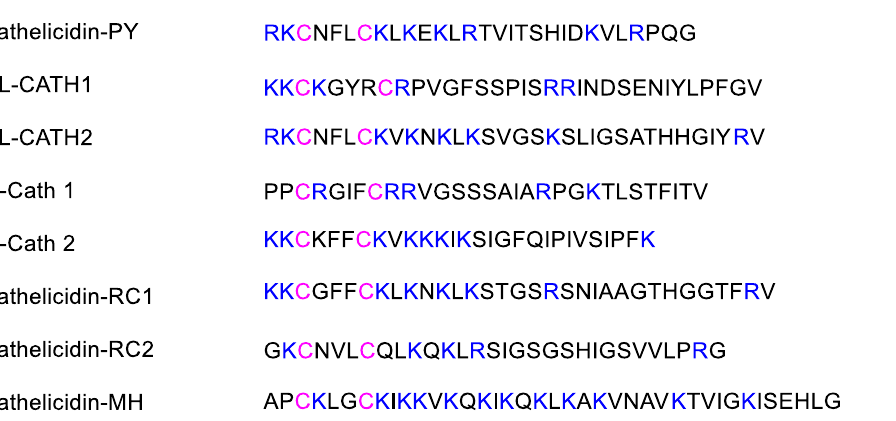
Figure 1. Sequence alignment of recently discovered amphibian cathelicidins, mature peptides shown. Blue denotes cationic residues and pink denotes the cysteine residues forming a disulfide bond.